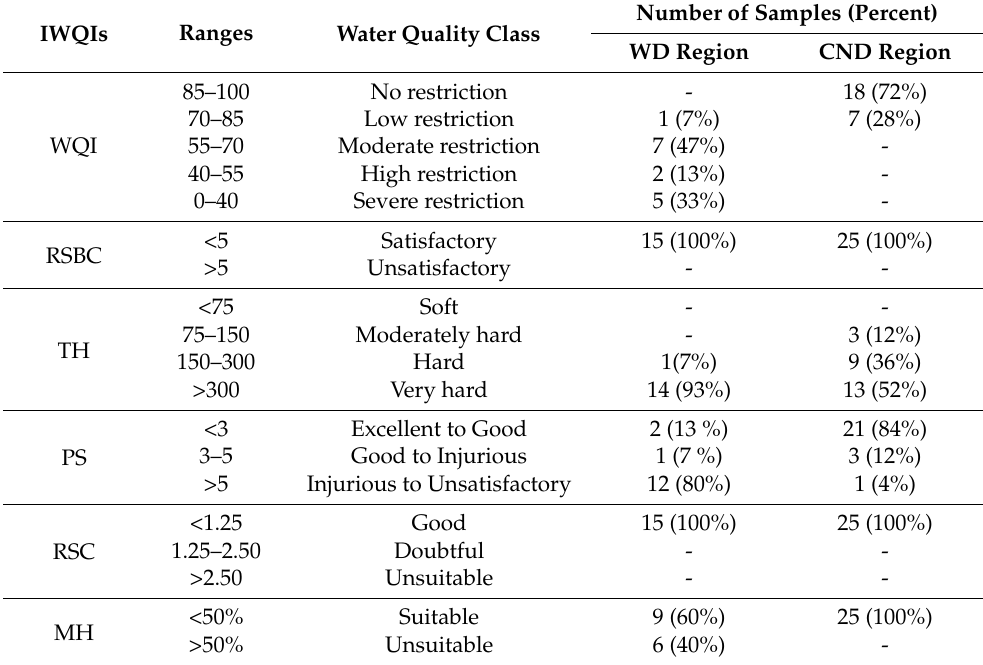
Table 4. Classification of groundwater quality based on different irrigation water quality indices (IWQIs) including water quality index (WQI), residual sodium bicarbonate (RSBC), total hardness (TH), potential salinity (PS), residual sodium carbonate (RSC), and magnesium hazard (MH) of groundwater samples collected from the Western Desert (WD) and Central Nile Delta (CND). Number of Samples (Percent) IWQIs Ranges Water Quality Class WD Region